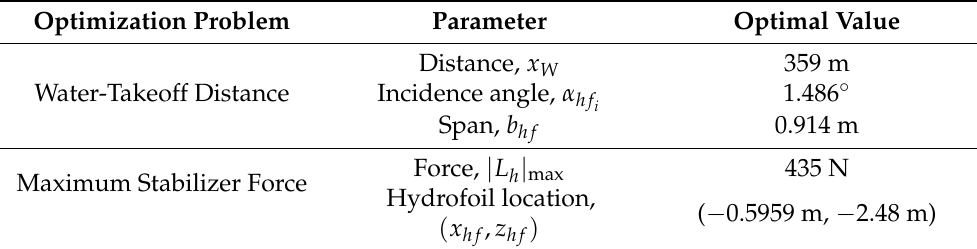
Table 6. Span length, incidence angle, and position optimization